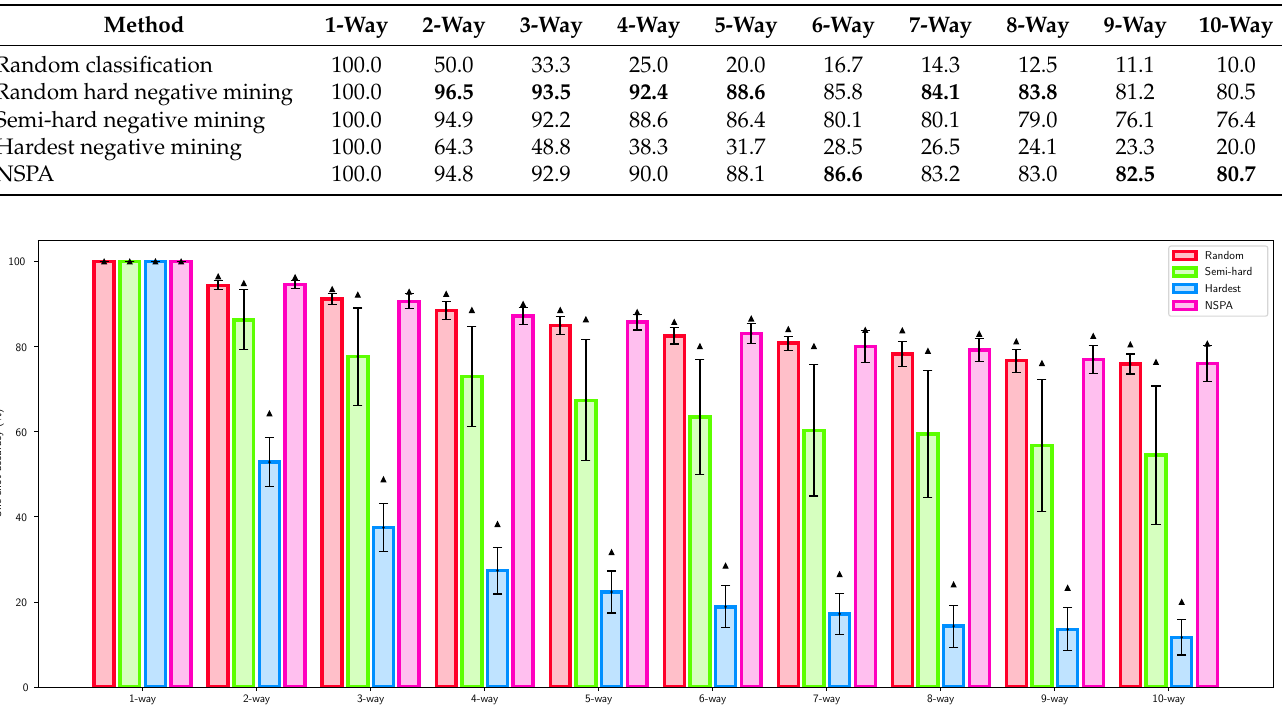
Table 1. One-shot classification accuracy on the NIST dataset when applying different methods, values are given in percentage (%). Classification accuracy was measured for n -way, referring to the number of selected classes. Values in bold are the best for each column. Random classification is the chance of randomly selecting the correct class; it is only shown for reference.